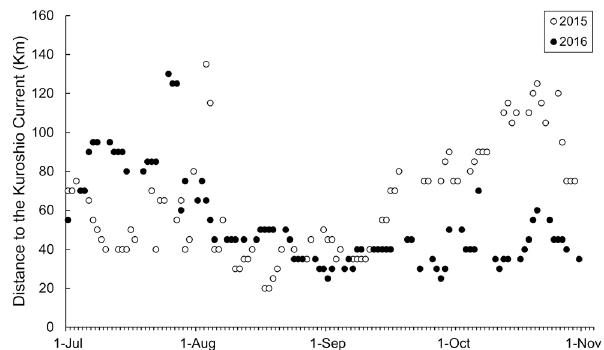
Figure 6. Distance from the Boso Peninsula [Cape Nojimazaki (34°54’N, 139°53’E)] to the centre of the Kuroshio Current from July to October 2015 and 2016 based on a database from the Hydrographic and Oceanographic Department, Japan Coast Guard (https://www1.kaiho.mlit.go.jp/KANKYO/KAIYO/